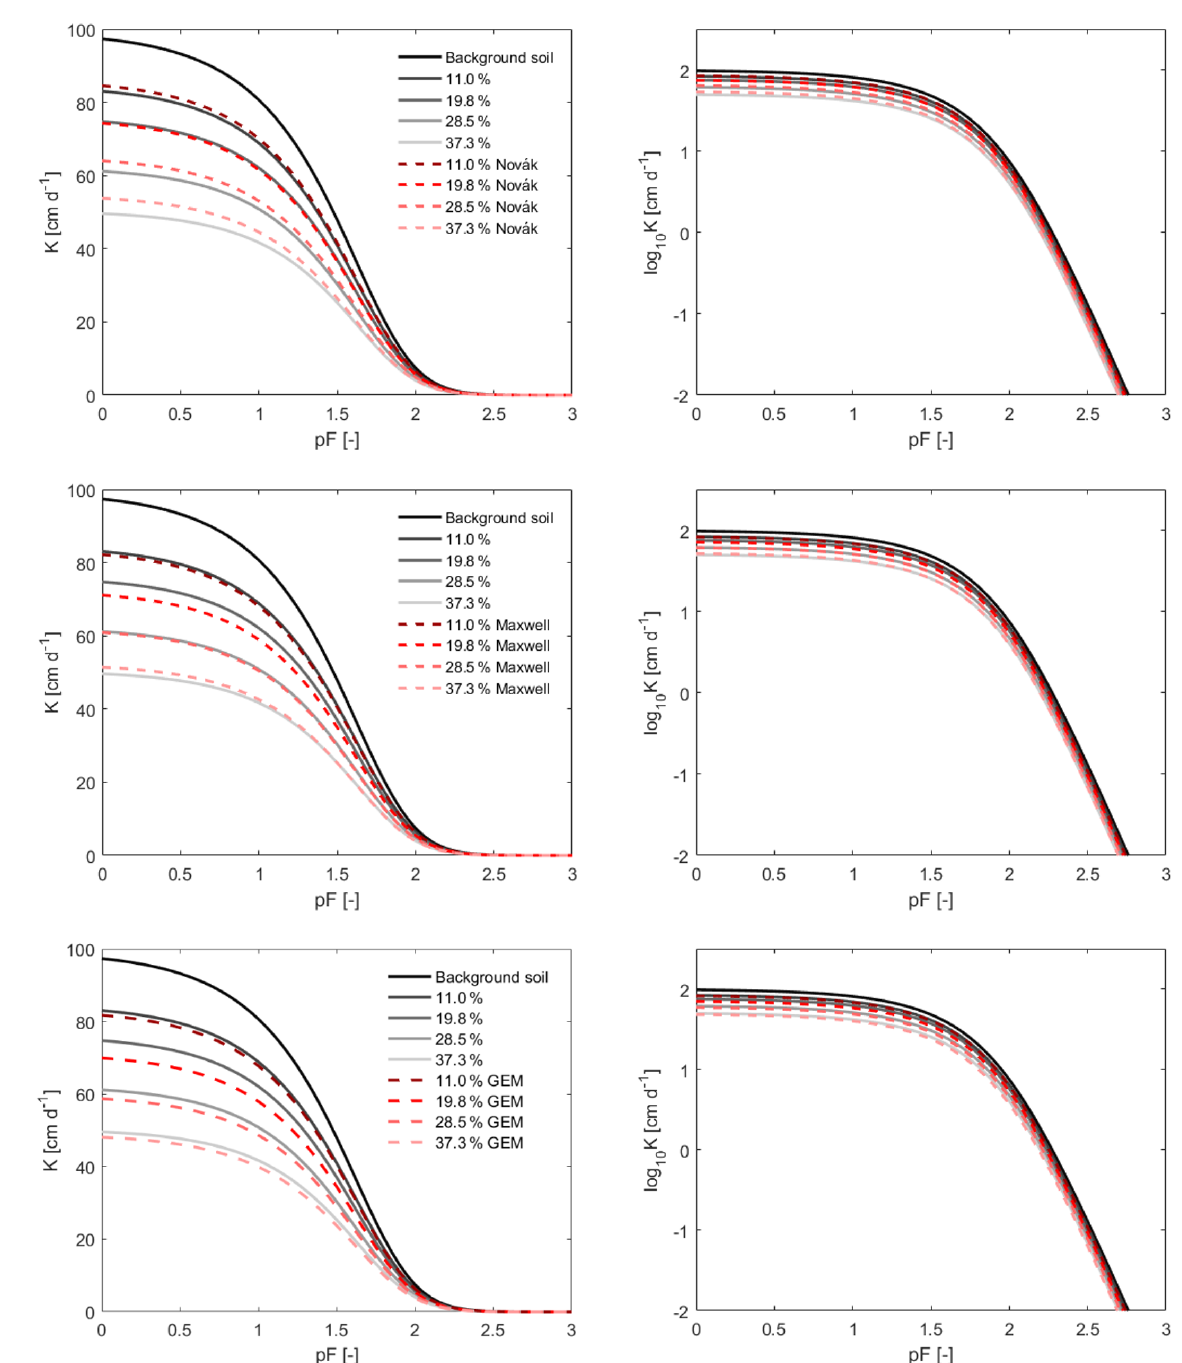
Figure 6. Evaluation of the Novák, Maxwell, and GEM models for scaling HCC of stony soils using the identified HCC as a benchmark. In each case, the HCCs were obtained for f = 11.0%, 19.8%, 28.5%, and 37.3% ( v/v ). The inverse identified curves are shown using solid lines, and the model results are shown using dashed lines. The value of f c in the GEM model was set as 0.982 with the corresponding shape parameter t = 1.473, and the parameter α = 1 . 2 was selected for the Novák model.